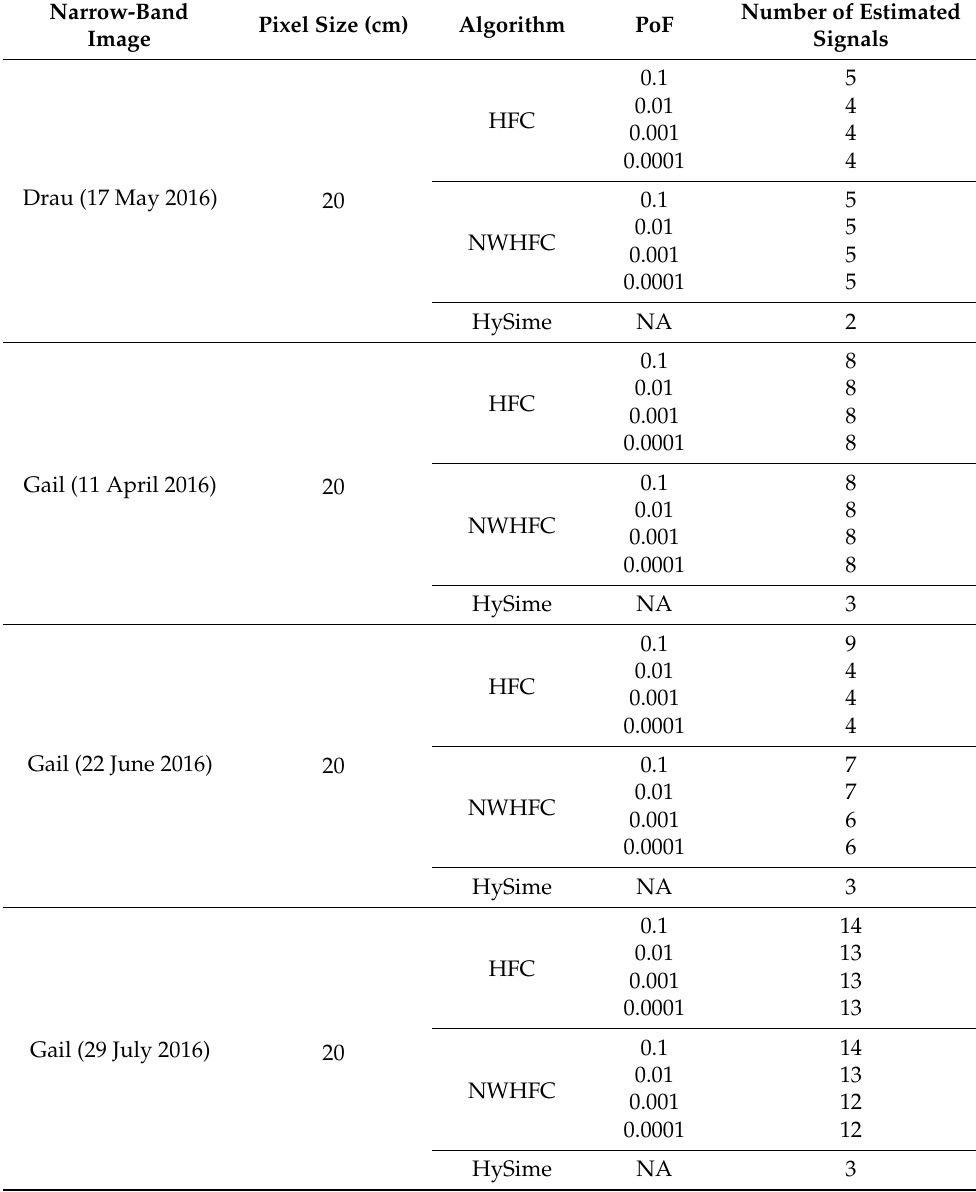
Table 4. The number of signals estimated by each algorithm and probability of failure (PoF) specifica- tion within each narrow-band image mosaic with 20 cm pixel